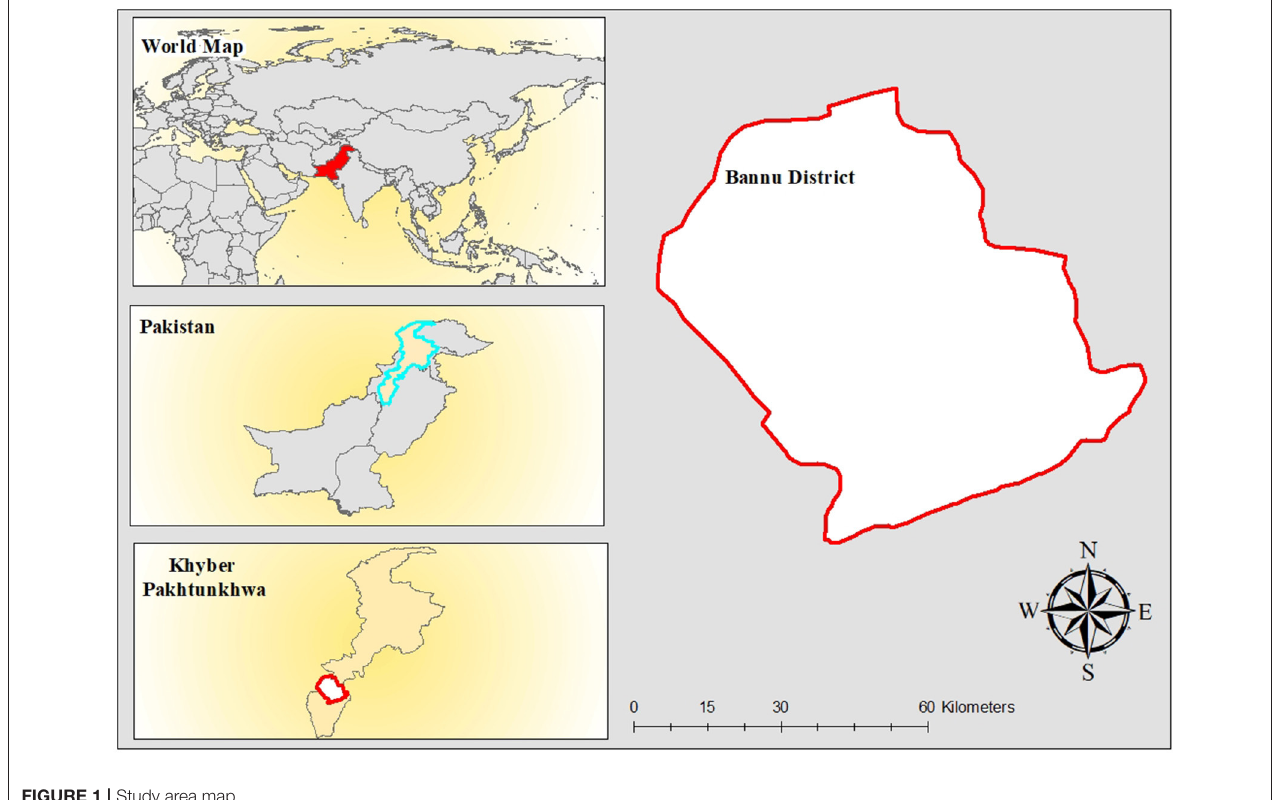
FIGURE 2 | Flow chart of malaria diagnosis in high-risk groups and treatment at health centers. PF, P. falciparum; PV, P. vivax; ACT (AS + SP), artemisinin combination therapy (artesunate + sulfadoxine – pyrimethamine); ACT (ART + LF), artemisinin combination therapy (artemether + lumefantrine) .